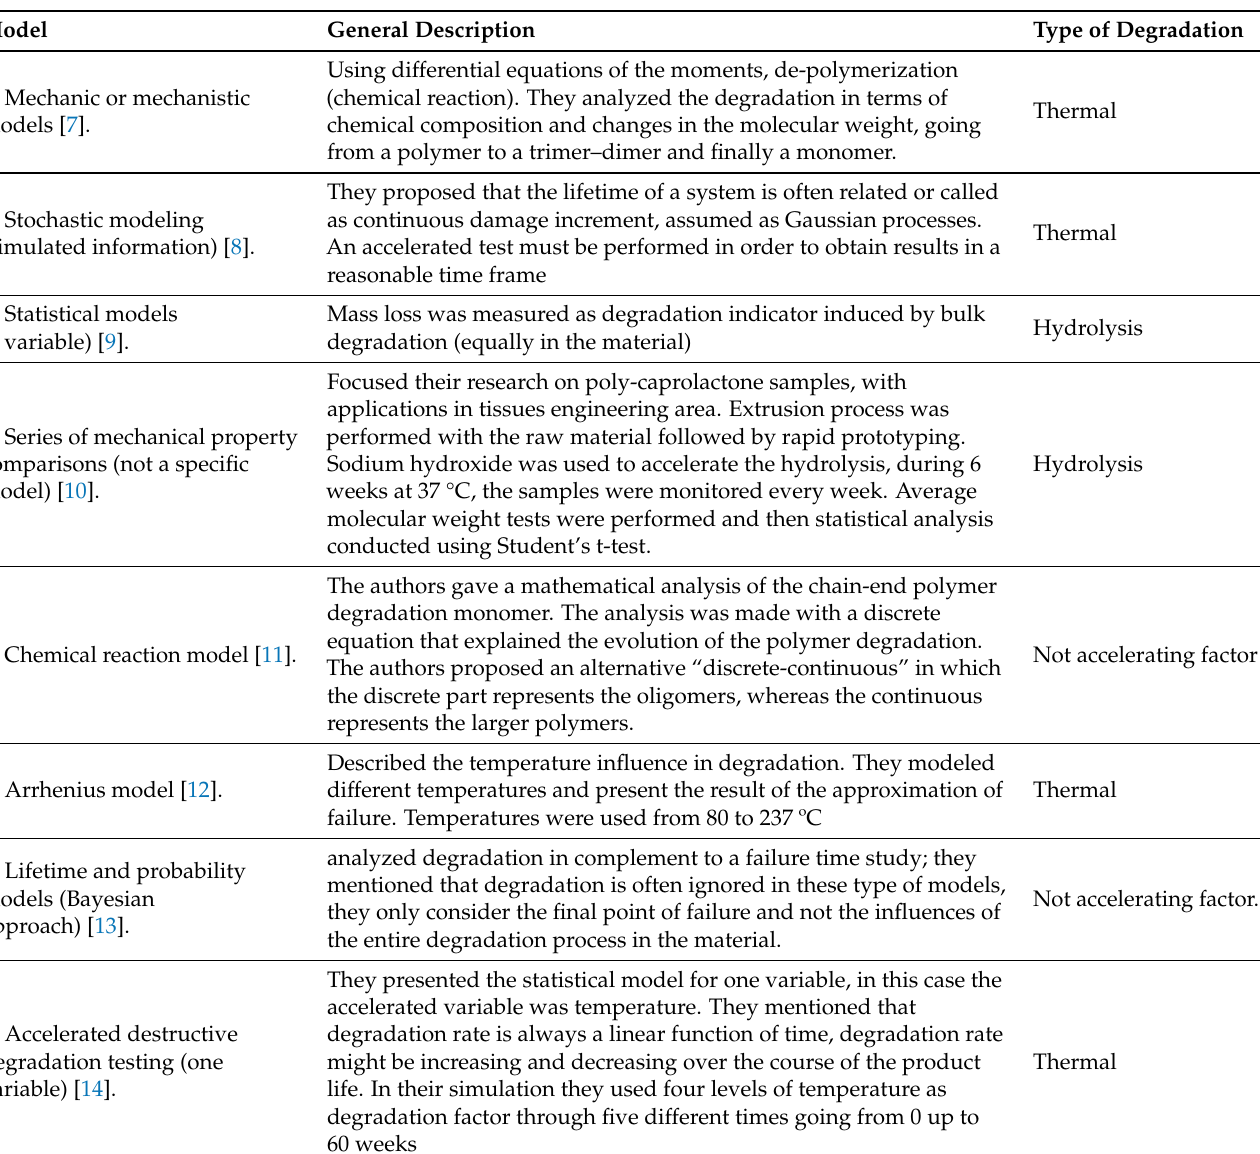
Table 1. Existing degradation